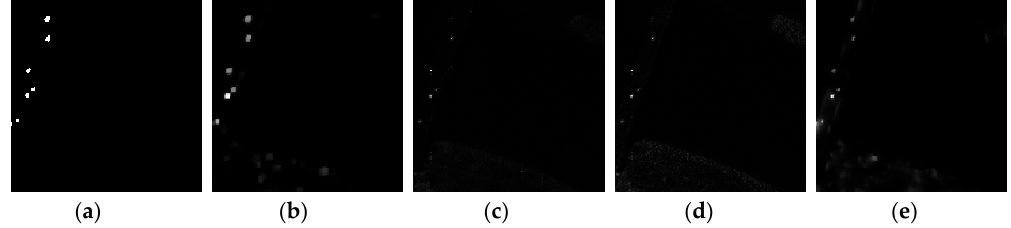
Figure 5. ABU-Beach detection map of the compared methods. ( a ) Reference map, ( b ) MPAF, ( c ) RX, ( d ) FrFE-RX, ( e ) AED.